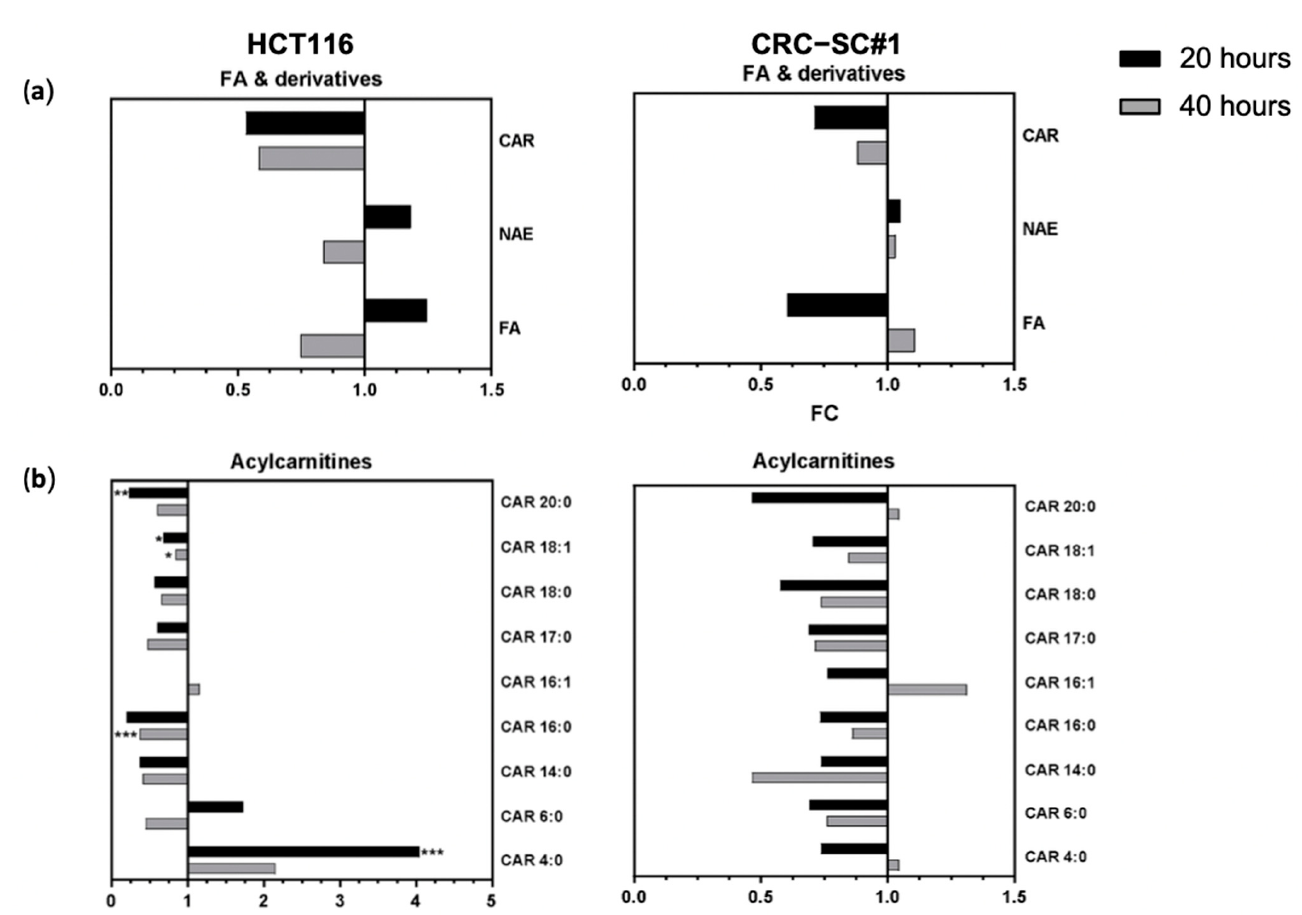
Figure 12. Lipidomic results for HCT116 and CRC-SC#1 cells. Graphs displaying the fold change for HCT116 cells (left panels) and CRC-SC#1 cells (right panels). The fatty acid derivatives are reported with the subclasses identified: acylcarnitine (CAR), N-acyl ethanolamines (NAE), and free fatty acids (FAs) ( a ). CAR characterization ( b ). Glycerophospholipids (GPLs) reported with the subclasses identified: glycerophosphoglycerol (GPG), glycerophosphoinositol (GPS), glycerophosphoinositols (GPIs), glycerophosphoethanolamine (GPE), and glycerophosphocholine (GPC) ( c ). For each class, the identified derivatives were reported considering both the lyso (LPS, LPI, LPG, LPE, LPC) and ether forms (PI-O, PG-O, PE-O, PE-P, PC-O) ( d ). *: Student’s t -test p < 0.1; **: Student’s t -test p < 0.01; ***: Student’s t -test p <